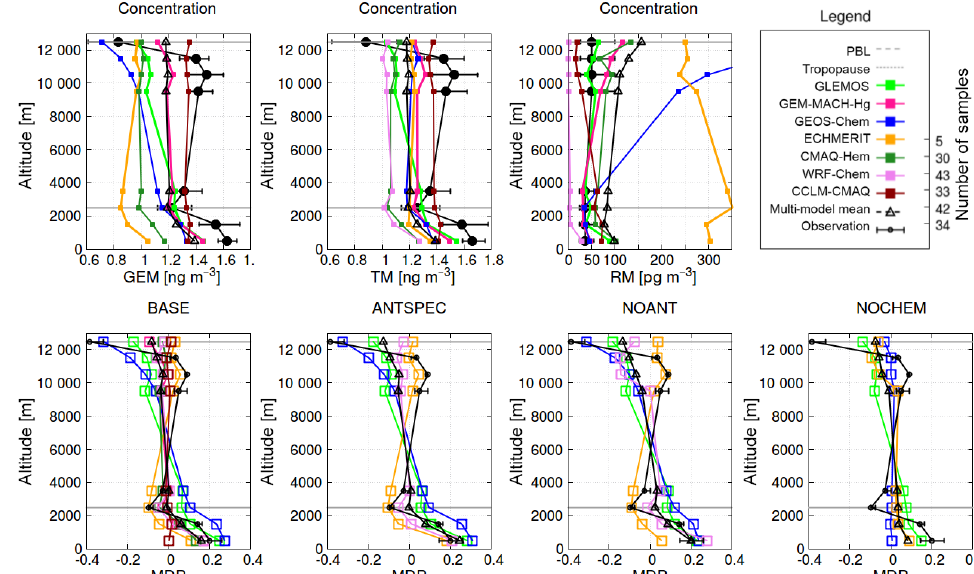
Figure 3. Comparison of modelled average mercury profile for Europe to observations based on vertical profiles from ETMEP and CARIBIC campaigns amended with ground-based observations at Waldhof and Mace Head (Weigelt et al., 2013; Slemr et al., 2016). The error bars indicate the 66% quantile range of the observations in each altitude; the sample size for each altitude is indicated on the y axis of the legend. The mean deviation profiles (MDP) are given for TM.